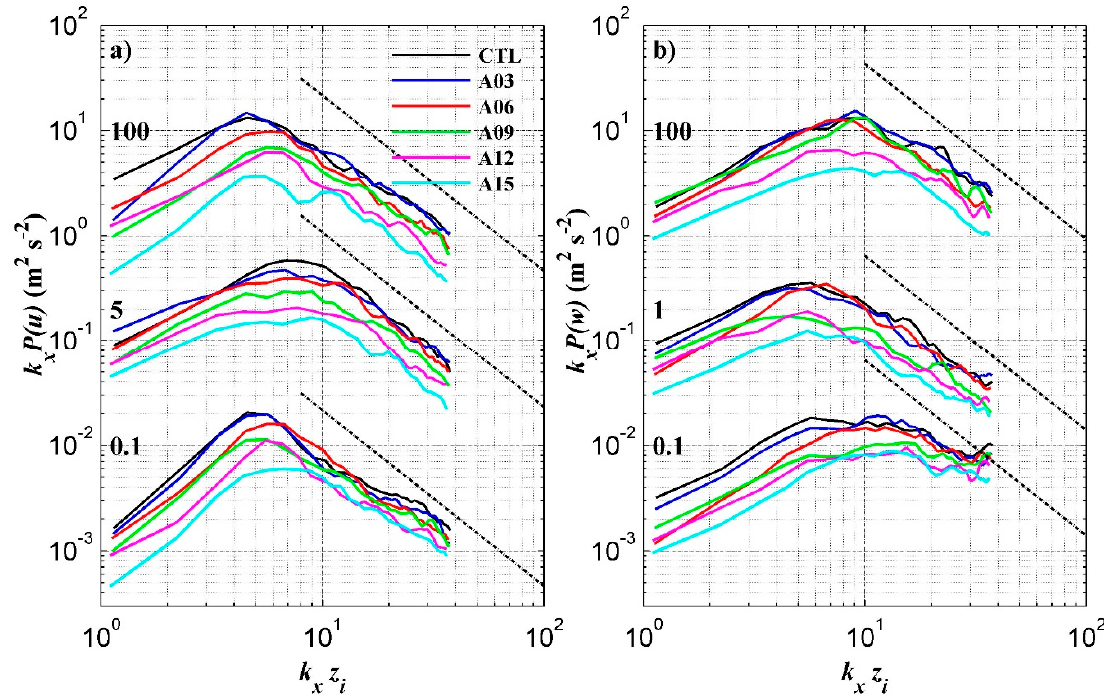
Figure 6. One-dimensional ( x ) spectra of ( a ) the u velocity component and ( b ) the w velocity component for the case with different AOD values and the free-atmosphere potential temperature gradient of 6 K km − 1 . The spectra at the top, middle, and bottom are multiplied by numerical factors on the left-hand side of the plot. The straight dashed lines indicate the − 5/3 power law. Black: CTL, AOD = 0; blue: A03, AOD = 0.3; red: A06, AOD = 0.6; green: A09, AOD = 0.9; magenta: A12, AOD = 1.2; cyan: A15, AOD = 1.5. k x z i: normalized wavenumber; k x P(u): u- component spectra ; k x P(w): w- component spectra .